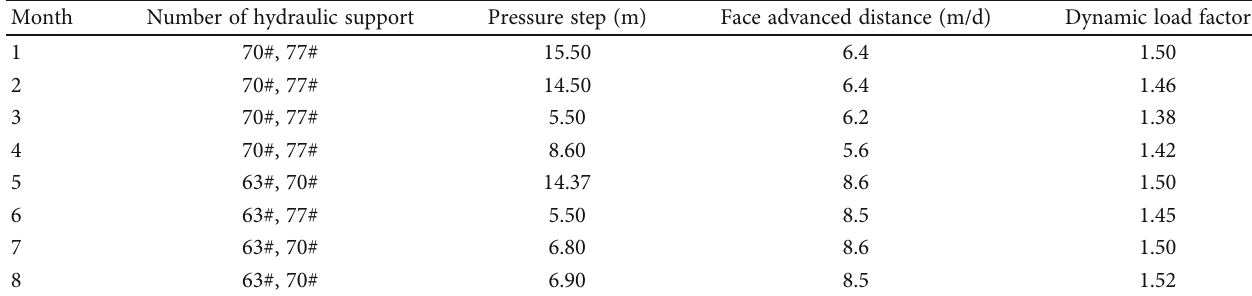
Table 5: Related data of working resistance of hydraulic supports (in the middle part of working face).